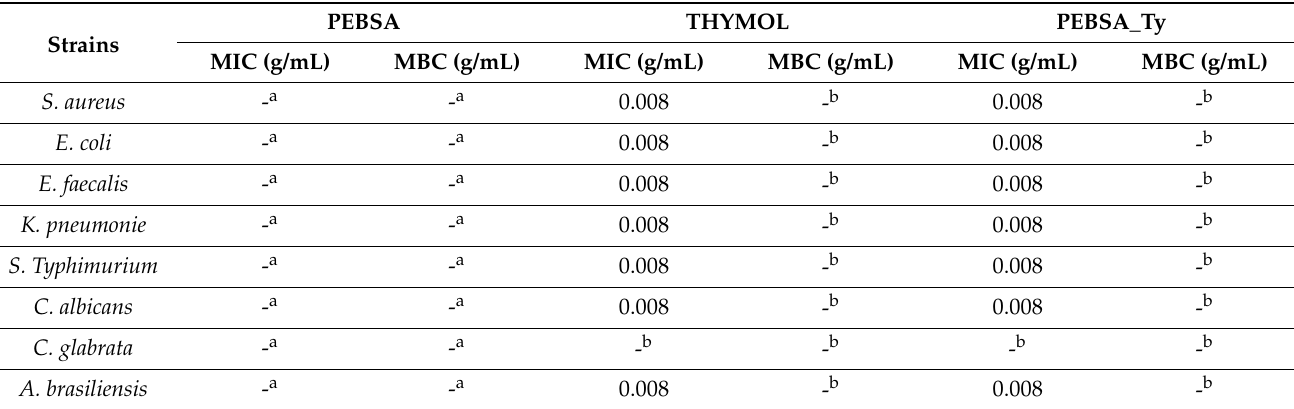
Table 3. Antimicrobial activities of the investigated